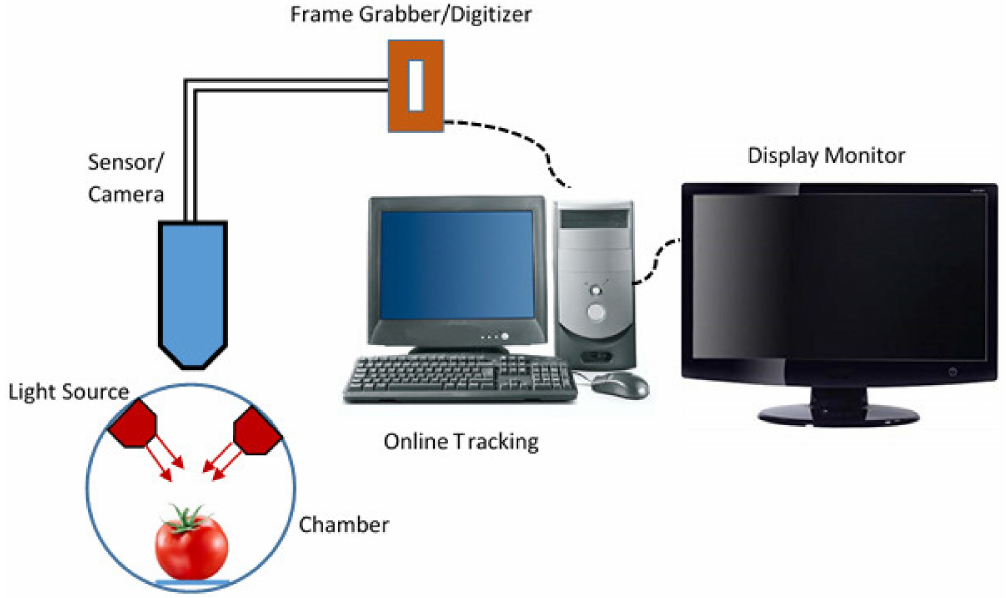
Figure 2. The basic concept and components of a typical machine vision